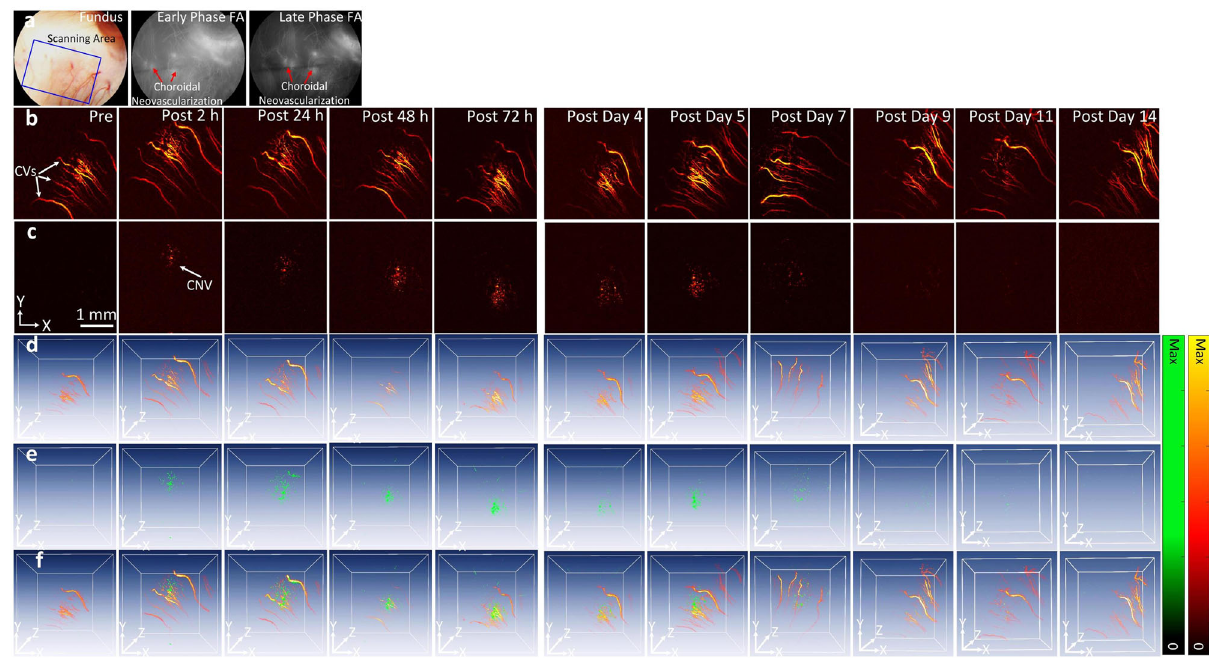
Fig. 7 Another study of contrast-enhanced PA detection of CNV model in living rabbits. a Color fundus photography and fl uorescein angiography images of the retina before injection of CGNP clusters-RGD. b , c PAM images of CNV acquired at 578 and 650nm before and after the injection of CGNP clusters-RGD (0.5mL at concentration of 2.5mg/mL). d Fused 3D visualization shown in b and c . The retinal vasculature is shown in red and the distribution of CGNP